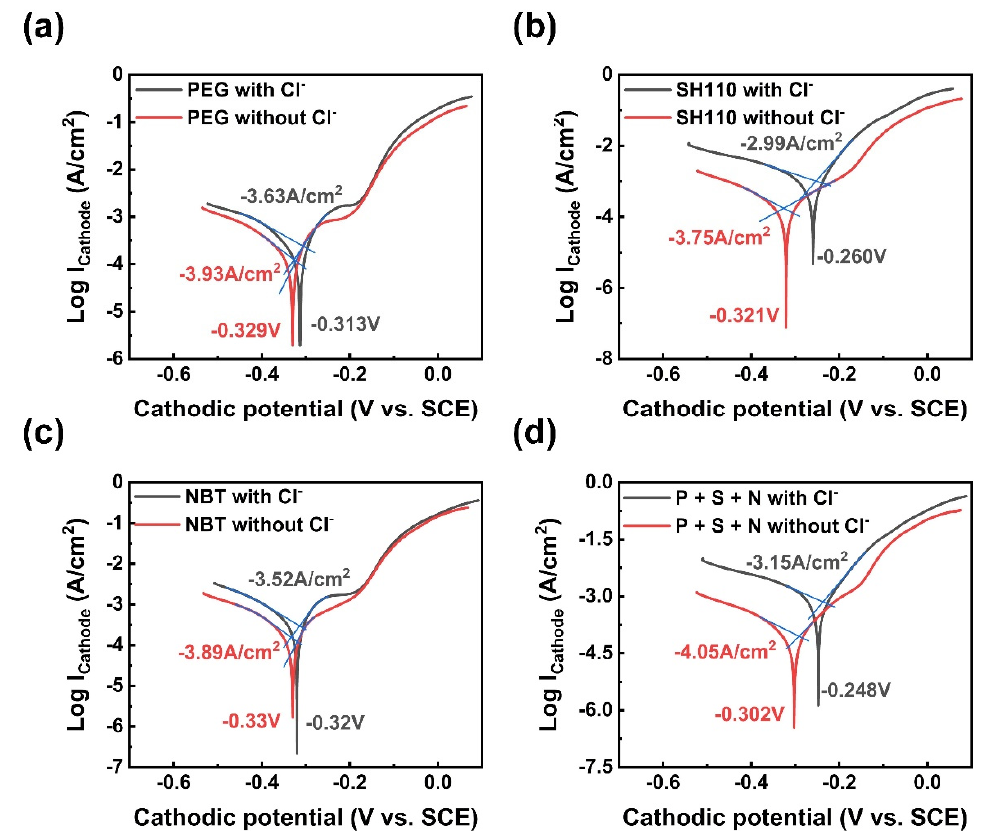
Figure 10. Potentiodynamic polarization curves measured in 3.5 wt.% NaCl solution for the copper coatings. ( a ) PEG, 200 mg/L; ( b ) SH110, 6 mg/L; ( c ) NBT, 5 mg/L; ( d ) PEG, 200 mg/L + SH110, 6 mg/L + NBT, 5 mg/L.